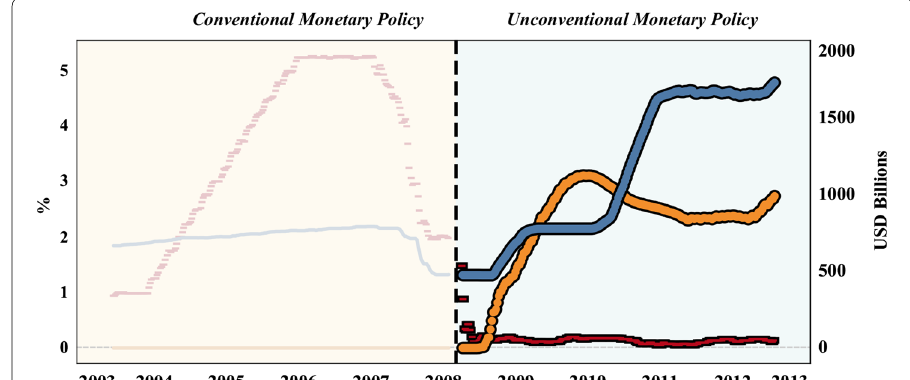
Fig. 1 US monetary policy instruments: Conventional: The Federal Funds Rate is initially colored light red and then dark red (left scale); Unconventional: The Fed’s TS and MBS holdings are initially colored light blue and orange and then dark blue and orange (right scale),